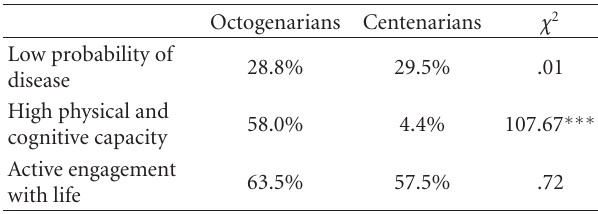
Table 2: Proportion of successful aging